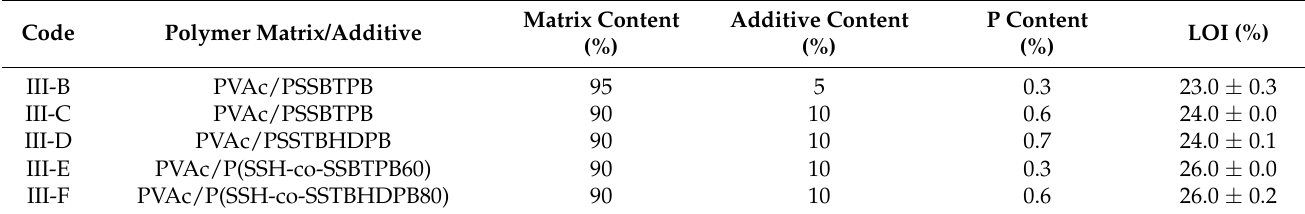
Table 4. LOI measurements of PVAc